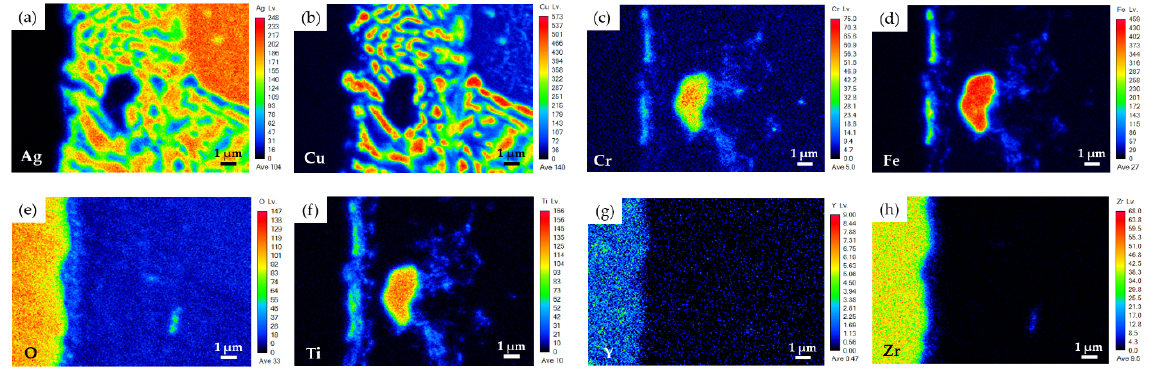
Figure 7. EPMA WDS element mappings of YSZ side in Figure 6c: ( a ) Ag, ( b ) Cu, ( c ) Cr, ( d ) Fe, ( e ) O, ( f ) Ti, ( g ) Y, and ( h ) Zr.